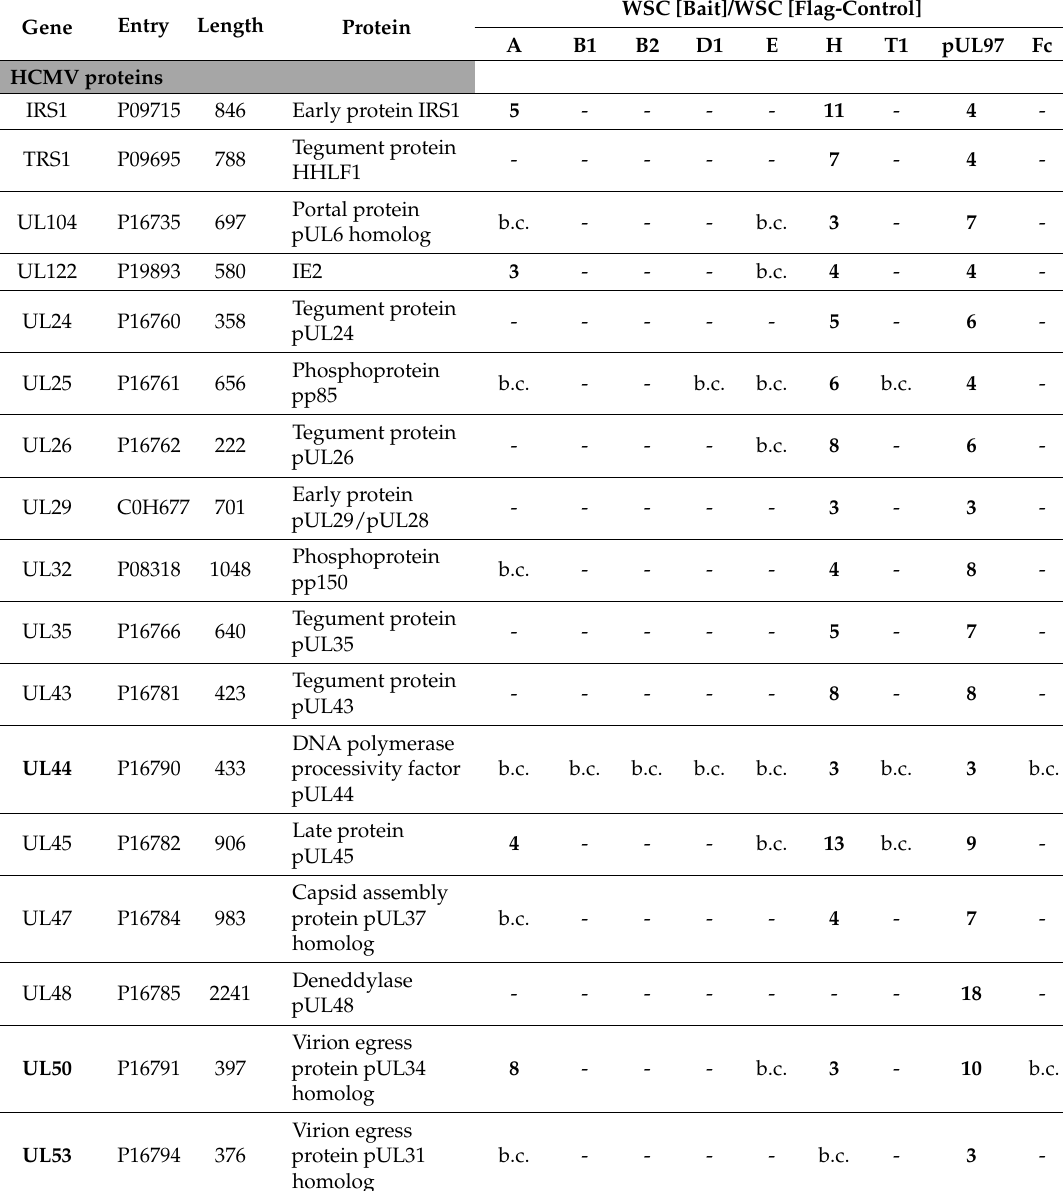
Table 3. Viral proteins and CDK/cyclin-specific proteins coimmunoprecipitated with antibodies against endogenous cyclins using lysates of HCMV-infected HFFs